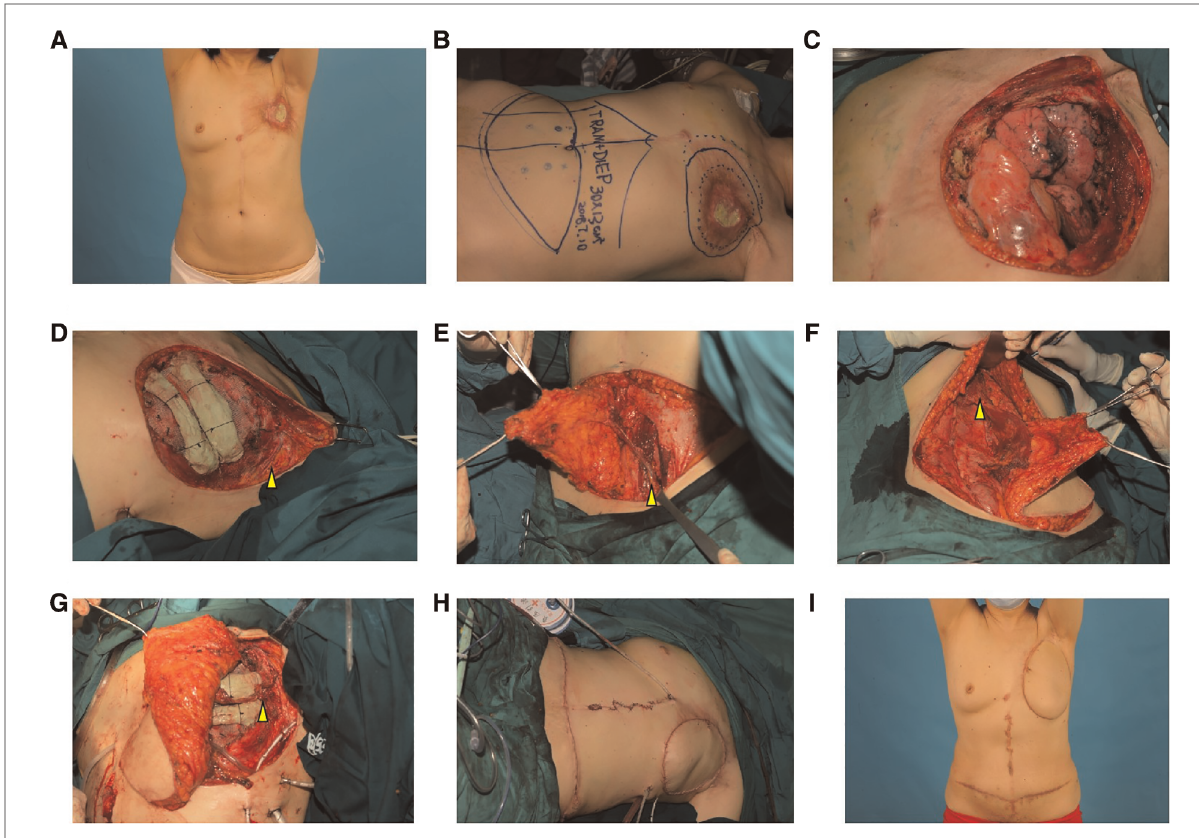
FIGURE 2 Surgical procedure and postoperative appearance of case 2 ( A ) , A preoperative photograph; ( B ), We designed a DIEP fl ap in combination with a TRAM fl ap to cover defects of the chest wall; ( C ), extensive excision of the lesion and the resulting huge full-thickness defect of the chest wall; ( D ), polypropylene knitted nonabsorbable mesh was sutured to the surrounding tissue, and two bars of methyl methacrylate were fi xed on the residual rib above the polymesh. We dissected the thoracic acromial artery and vein as recipient vessels, as indicated by the arrows; ( E ), The DIEP fl ap was raised on the left side of the abdomen, and the arrow shows the inferior epigastric artery and vein; ( F ), The TRAM fl ap was raised on the right side of the abdomen, and the arrow shows the muscle pedicle; ( G ), The fl ap was transferred to the chest wall, and microsurgical end-to- end anastomosis was performed between the fl ap and the recipient vessels. (The arrow shows the thoracic acromial artery and vein); ( H ), Immediate postoperative photograph; ( I ), After 35 months of